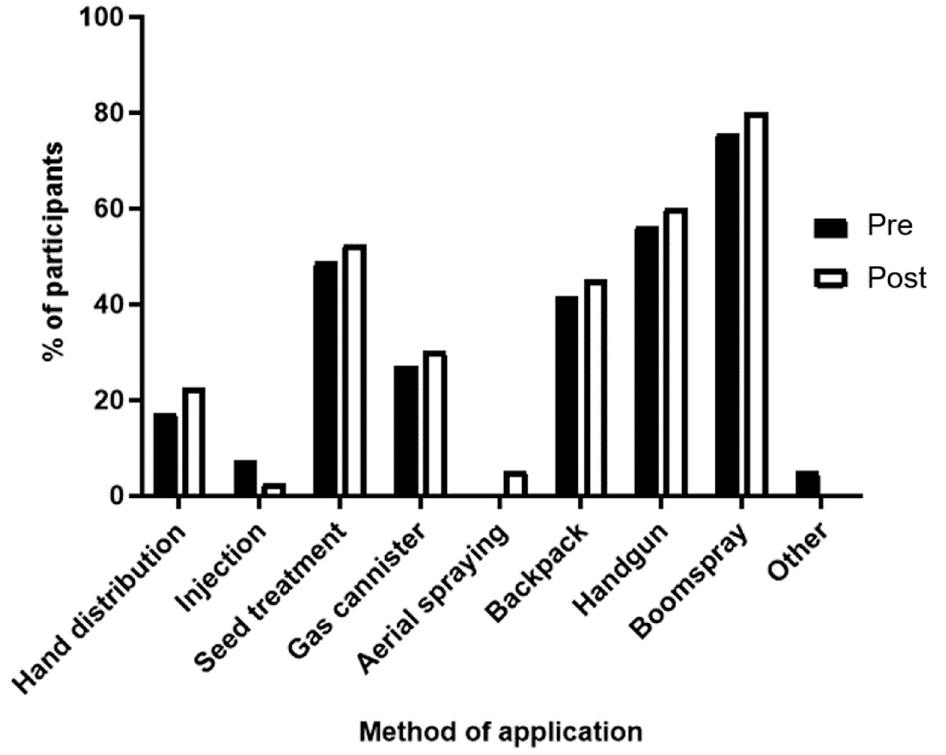
Figure 2. Pre- and post-methods of pesticide application used on farm to apply agrichemicals, following the PCAP research study. N = 41.